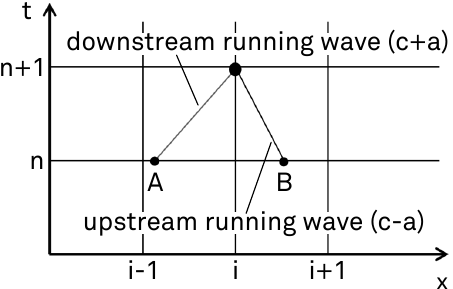
Figure 4. Time-space-grid with indicated base points A / B for positive direction of flow.